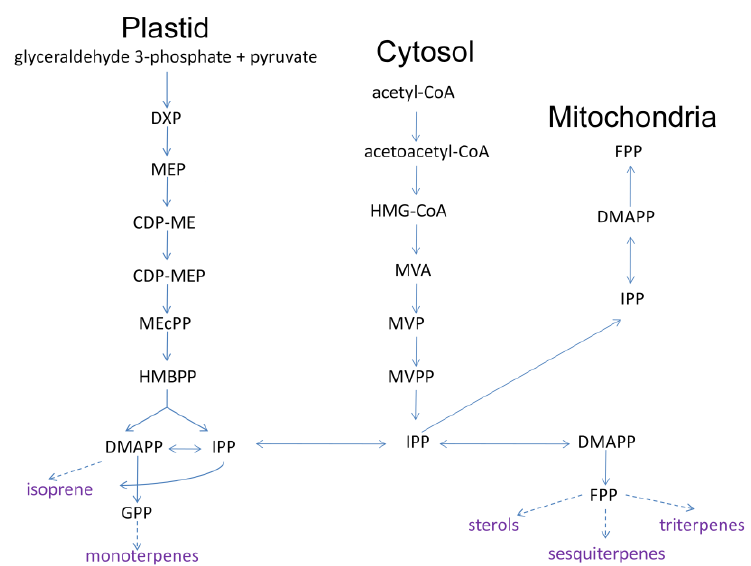
Figure 3. MEP and MVA pathway of terpenoids biosynthesis in plants (DXP, deoxyxylu- lose-5-phosphate; CDP-ME, 4-CDP-2-C-methyl-D-erythritol; CDP-MEP, CDP-ME 2-phosphate; phosphate; CDP-ME, 4-CDP-2-C-methyl-D-erythritol; CDP-MEP, CDP-ME 2-phosphate; MEcPP, MEcPP, 3-methyl-1,2,3,4-tetrahydroxybutane-1,3-cyclic bisphosphate; HMBPP, 3-methyl-1,2,3,4-tetrahydroxybutane-1,3-cyclic bisphosphate; HMBPP, (E)-4-Hydroxy-3-methylbut-2- (E)-4-Hydroxy-3-methylbut-2-enyl diphosphate; HMG-CoA, 3-hydroxy-3-methylglutaryl CoA; enyl diphosphate; HMG-CoA, 3-hydroxy-3-methylglutaryl CoA; MVP, 5-phosphomevalonate; MVPP, MVP, 5-phosphomevalonate; MVPP, 5-diphosphomevalonate) (Adapted with permission from 5-diphosphomevalonate) (Adapted with permission from Ref. [21]. 2022, Du, Y.; Zhou, Ref. [21]. 2022, Du, Y.; Zhou, H.).